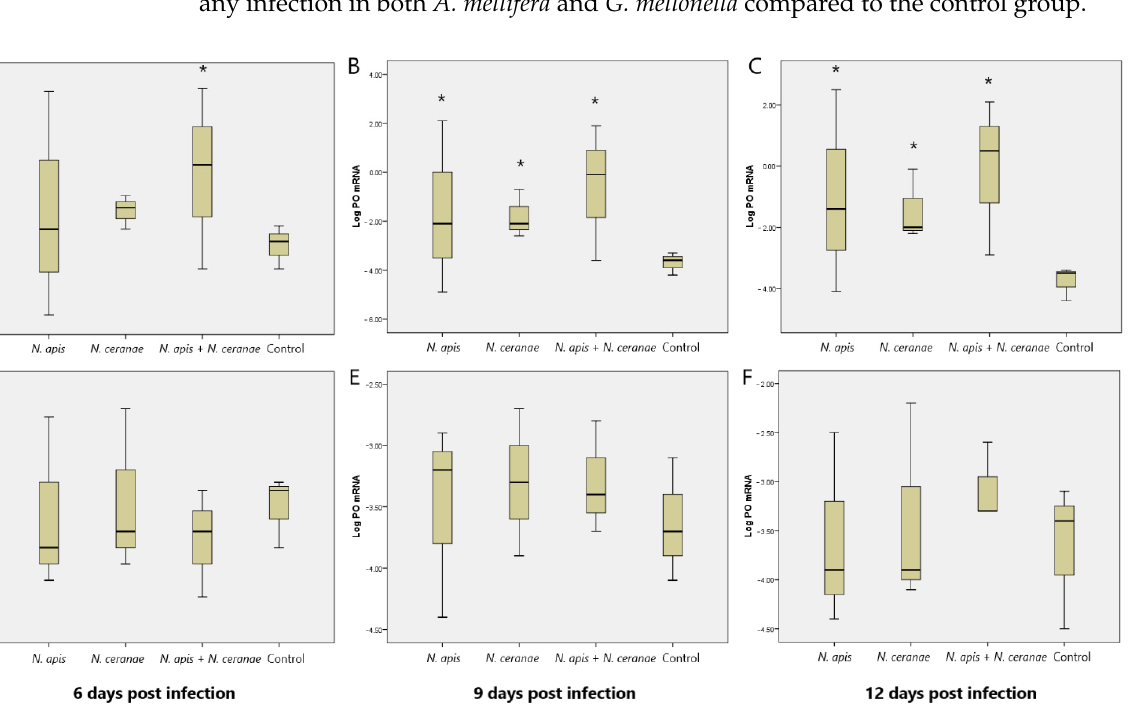
Figure 5. Effect of time-dependent N. apis and N. ceranae infection on the expression of Phenoloxidase-related gene in A. mellifera at 6, 9 and 12 days post-infection (( A ), ( B ) and ( C ), respectively) and G. mellonella at 6, 9 and 12 days post-infections (( D ), ( E ) and ( F ), respectively) (box plots graphics). Asterisks indicate statistically significant differences (Kruskal–Wallis, p < 0.05).